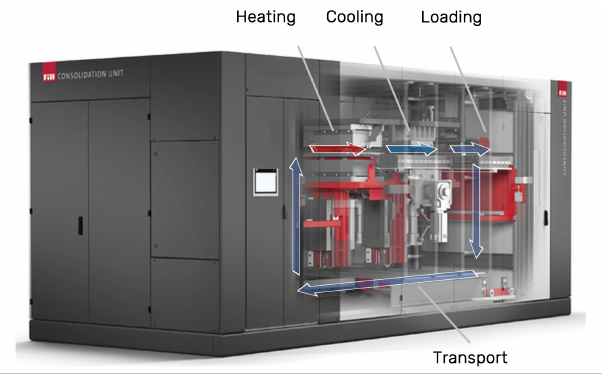
Figure 6. Consolidation unit used for experimental validation (Adapted with permission from [33]. 2022, FILL GESELLSCHAFT